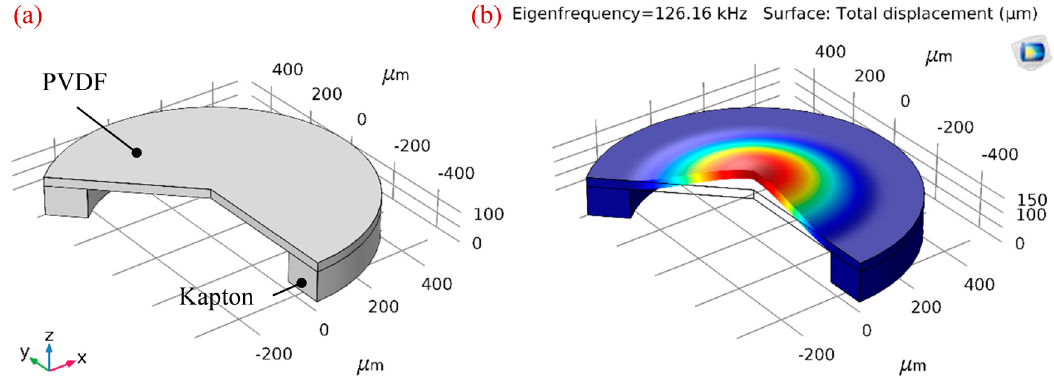
Figure 4. The simulation results of PVDF based monolayer structure. ( a ) Simulation model built in COMSOL Multiphysics 5.3; ( b ) vibration mode shape at the resonant frequency of 126.16 kHz.